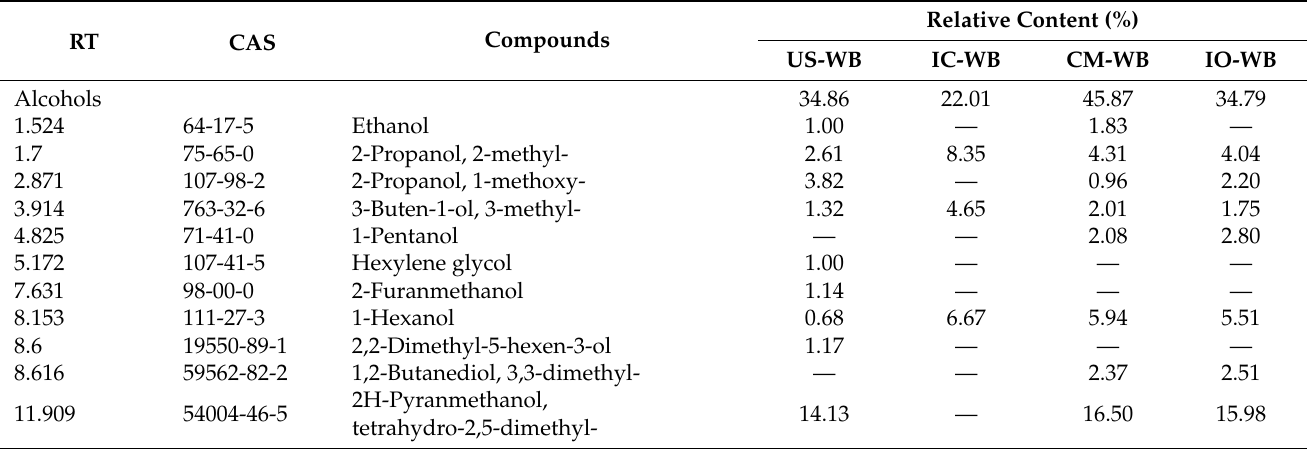
Table 2. Volatile compounds in unfermented sterilized wheat bran (US-WB) and fermented wheat brans after 6 days of fermentation. IC-WB, Isaria cicadae Miq. fermented wheat bran; CM-WB, Cordyceps militaris fermented wheat bran; IO-WB, Inonotus obliquus fermented wheat